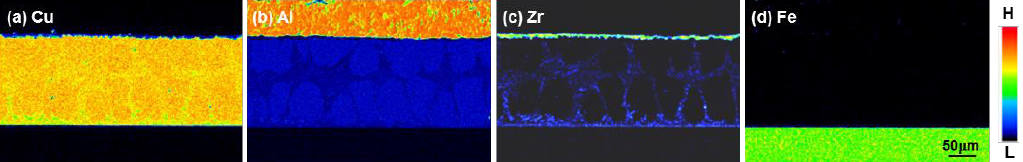
Figure 3. FE-EPMA mapping of Cu, Al, Zr, and Fe elements for the α-Al 2 O 3 /Cu-7Al-3.5Zr/SS 430 joint brazed at 1000 °C for 0 min ( a – d ).